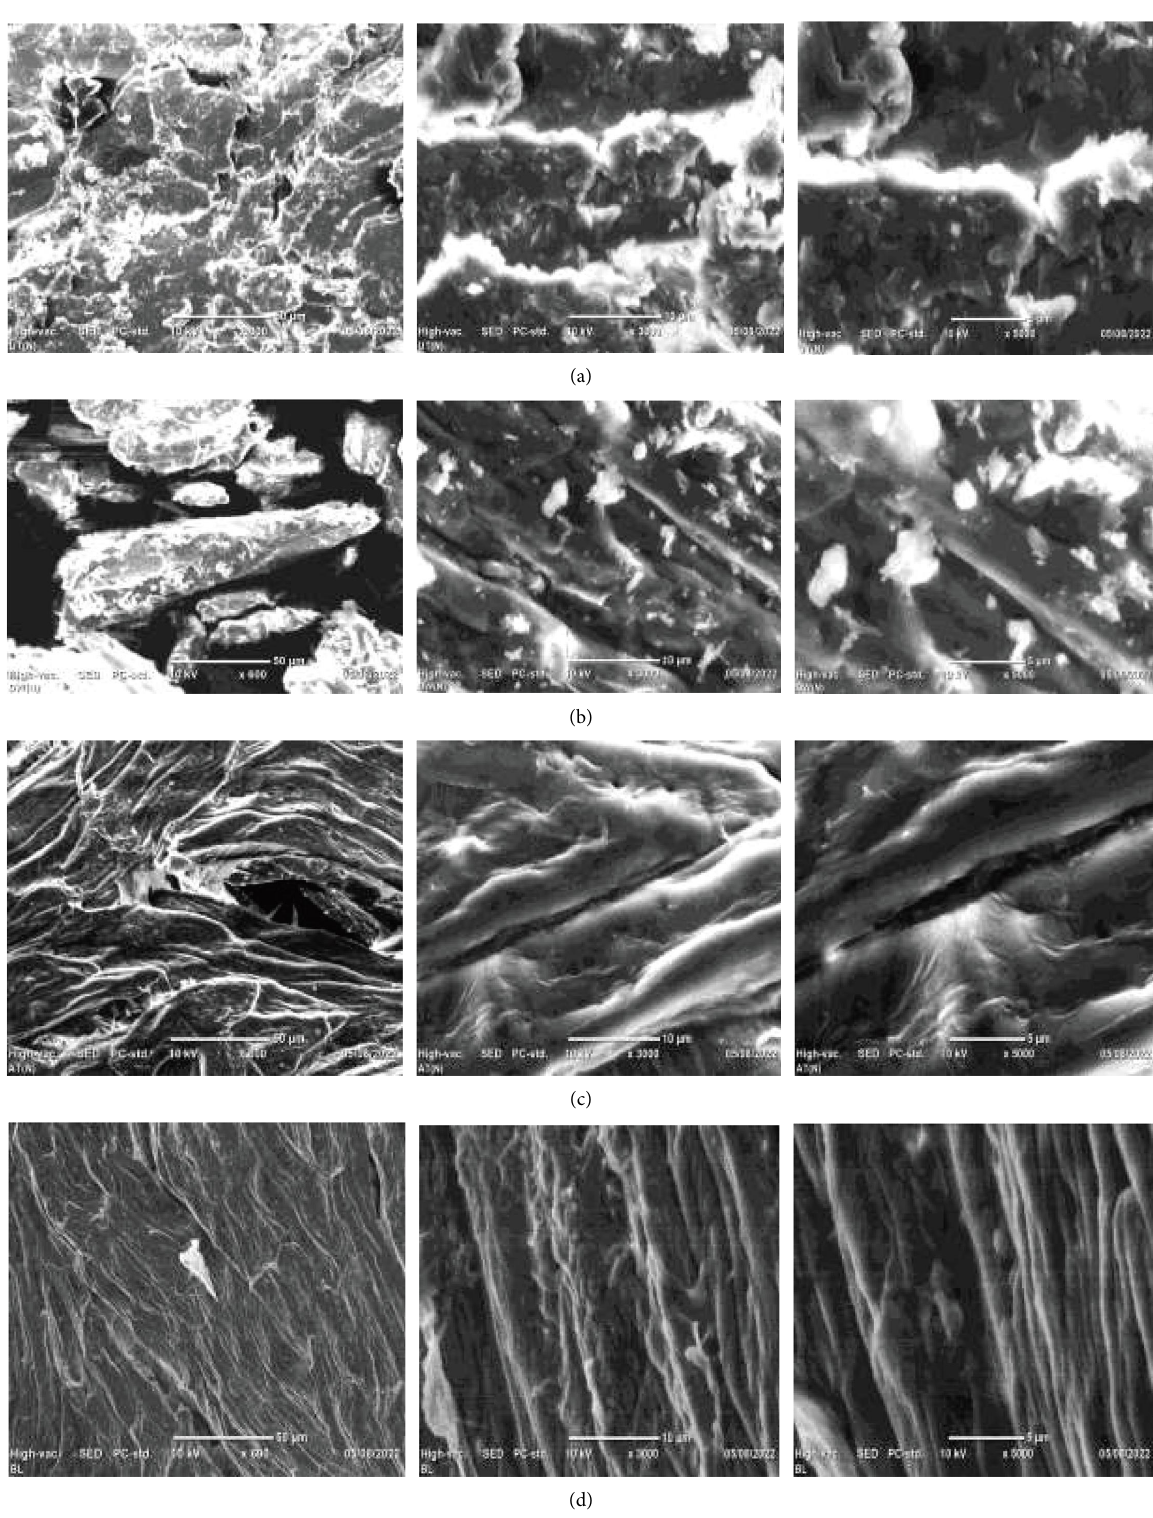
Figure 6: SEM micrograph of untreated (a), dewaxed (b), alkali-treated (c), and bleaching (d) sample of outer skin-isolated cofee husk